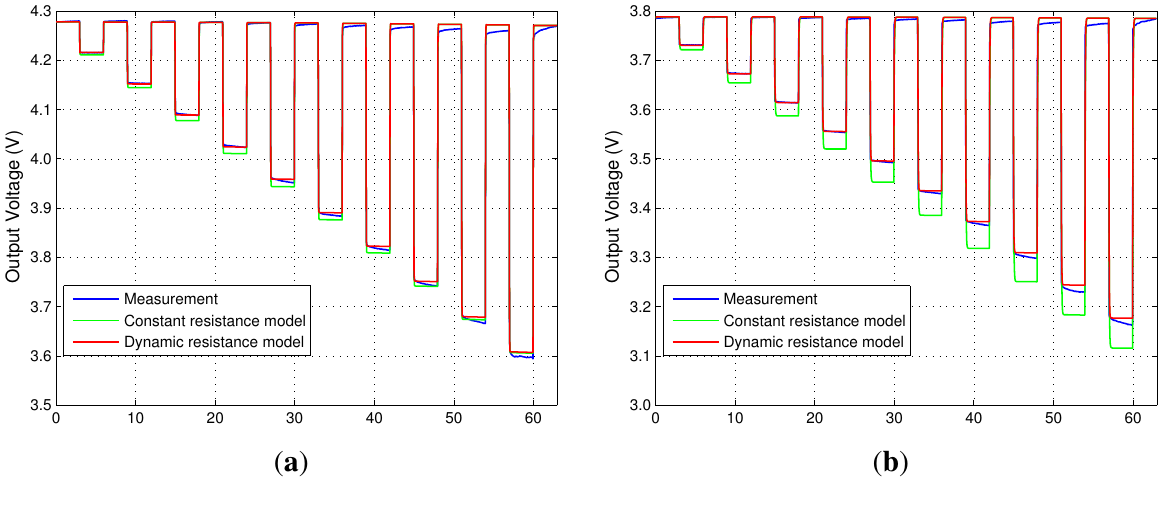
Figure 6. Comparison of the modeling performance: at ( a ) 100% SOC; and ( b ) 50%